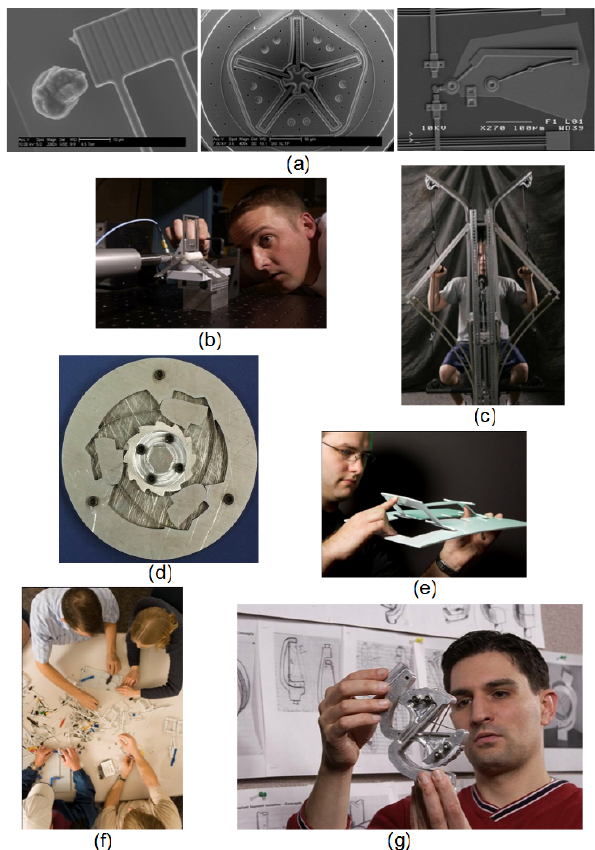
Figure 1. Examples of compliant mechanisms designed by the CMR: (a) scanning electron micrographs of compliant micro mech- anism next to a white blood cell, a micro compliant joint for high g-loads, and a micro bistable mechanism, (b) a high precision de- vice for nanoscribing, (c) an exercise device with specified force- displacement characteristics, (d) a compliant overrunning (one- way) clutch, (e) a lamina emergent mechanism (LEM), (f) a custom prototyping kit, compatible with Legos, to facilitate quick design and testing of compliant mechanisms, and (g) a compliant pros- thetic